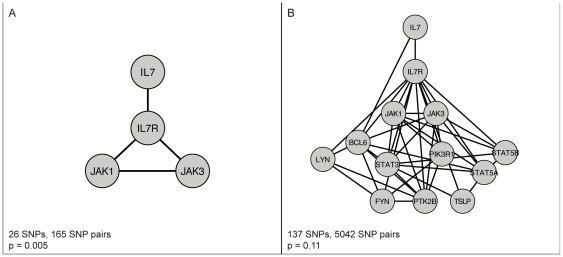
ARTP of IL7 sub-networks.Sub-networks used for the ARTP analysis and their results. (A) IL7 “core” module; (B) extended module considering all first neighbor interactions of IL7R.